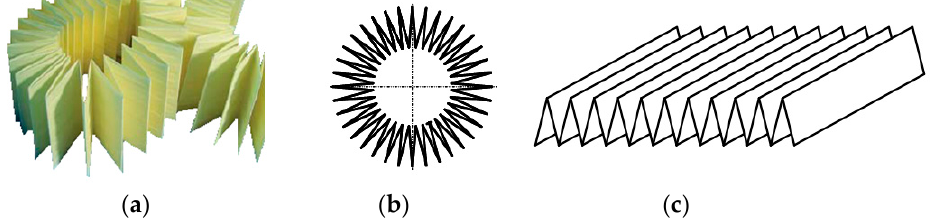
Figure 1. Shaping of filter paper: ( a ) paper after pleating, ( b ) shaping into a multi-armed star, ( c ) shaping into a panel.